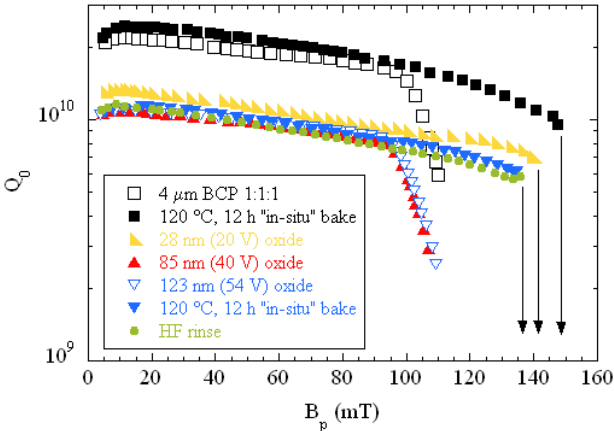
FIG. 2. (Color) Q vs B measured at 1.7 K for several surface p 0 treatments. The Q -drop reoccurs at the same field as after the BCP treatment by anodizing the surface of the baked cavity at 40 V. The vertical arrows indicate the quench field. An increase was observed as a consequence of field emission loading of R 0 res (cid:6) 45 MV = m ( B (cid:6) 110 mT ) in the test after the starting at E p p first in situ bake and caused a reduction of the low-field Q subsequent